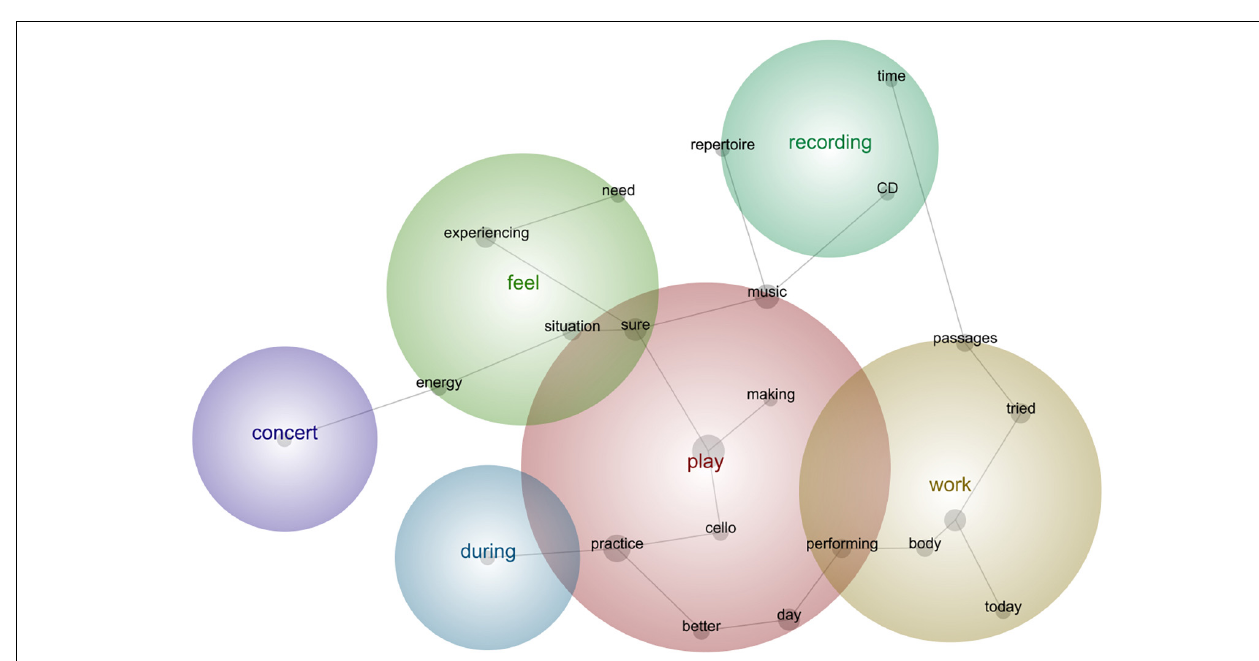
FIGURE 13 | Leximancer concept map for Concert